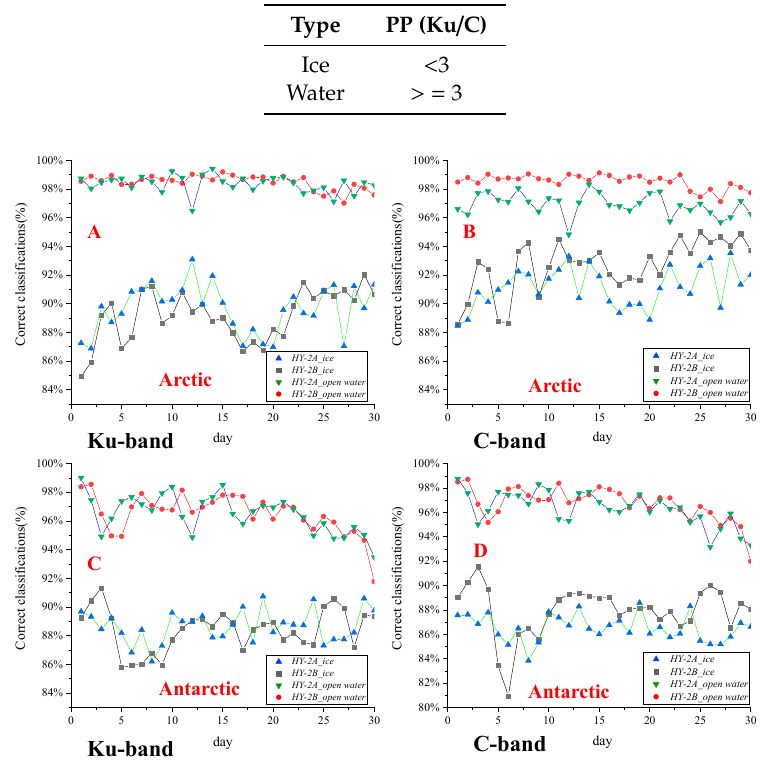
Table 2. Threshold segmentation.